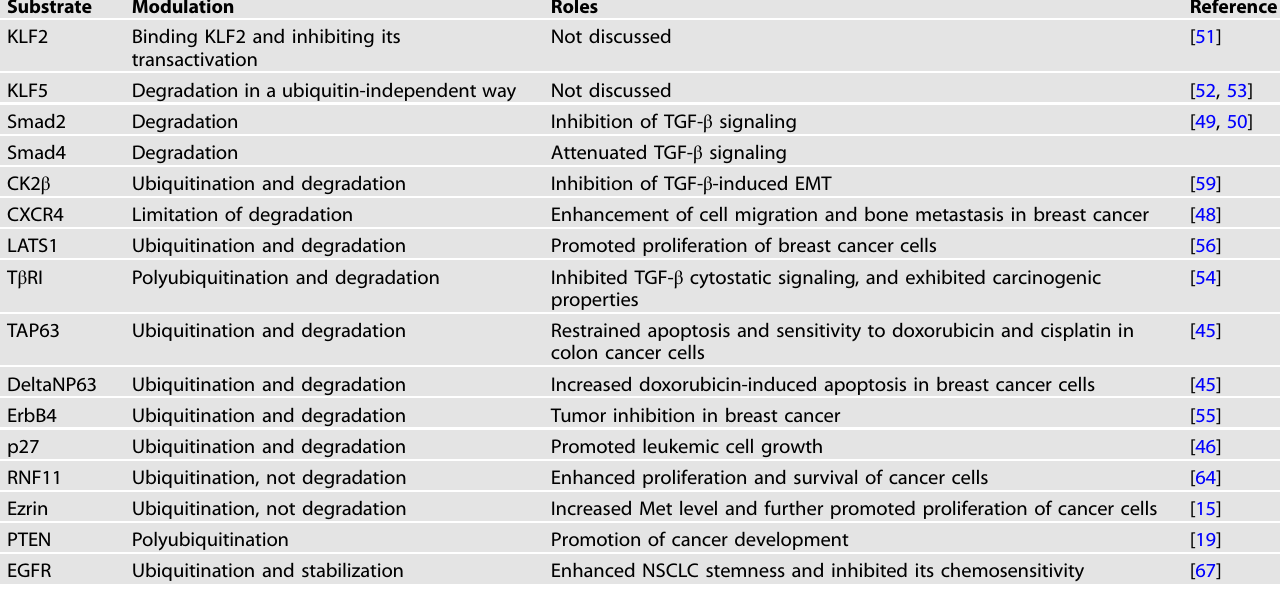
Table 2. Main cancer-related substrates of